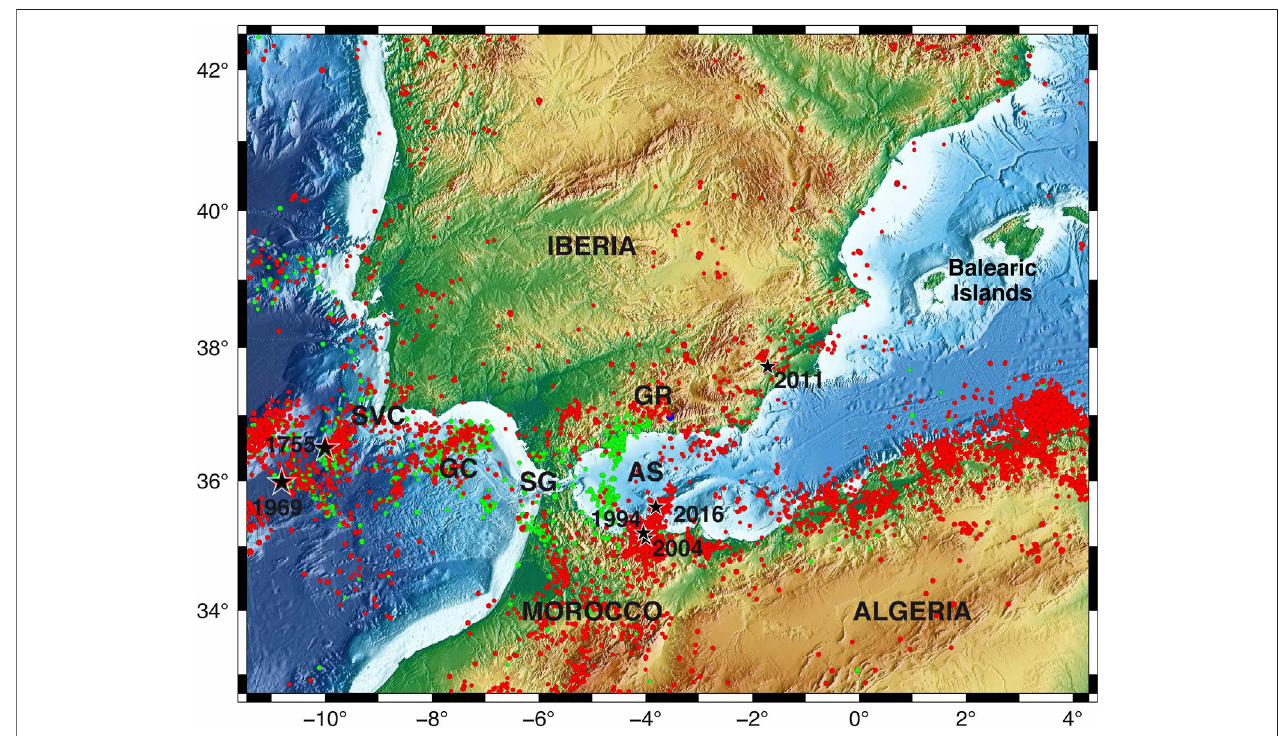
FIGURE 1 | Seismicity of the Ibero – Maghrebian Region for the period of 2000 – 2019 (M ≥ 3.0) taken from the IGN catalog (https://www.ign.es/web/ign/portal/sis- catalogo-terremotos). Red circles correspond to shallow earthquakes (h < 40 km), green to intermediate depths (40 < h < 150 km), and blue to deep events (h > 150 km). Stars show the epicenters of large or recent earthquakes. SG (cid:1) Strait of Gibraltar, SVC (cid:1) Saint Vincent Cape, GC (cid:1) Gulf of Cadiz, AS (cid:1) Alboran Sea, and GR (cid:1) Granada.